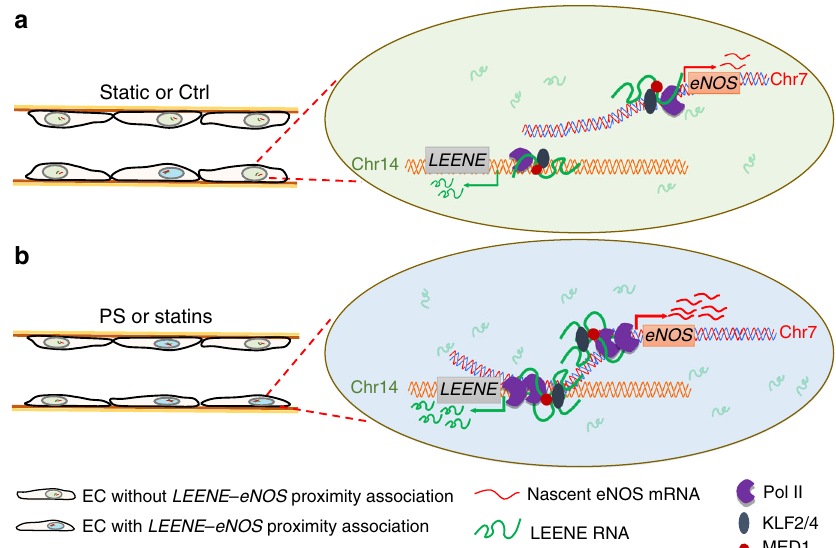
Fig. 8 Schematic illustration of LEENE – eNOS regulatory mechanism. The LEENE -associated enhancer (located in chr14) forms proximity association with eNOS locus (in chr7) under both static/basal/control (ctrl) ( a ) and stimulated conditions (PS or statins) ( b ), but is at a higher probability in the latter condition. In both conditions, KLF2 and KLF4 transcriptionally regulate LEENE and eNOS through binding to TFBS in the promoters of both genes. The LEENE RNA transcripts serve as guides to facilitate RNA Pol II binding to the promoter of eNOS . This enhancer lncRNA-mediated transcriptional regulation positively modulates the nascent eNOS mRNA synthesis to promote endothelial RNase-free water and same volume of RNA was used for reverse-transcript and qPCR.